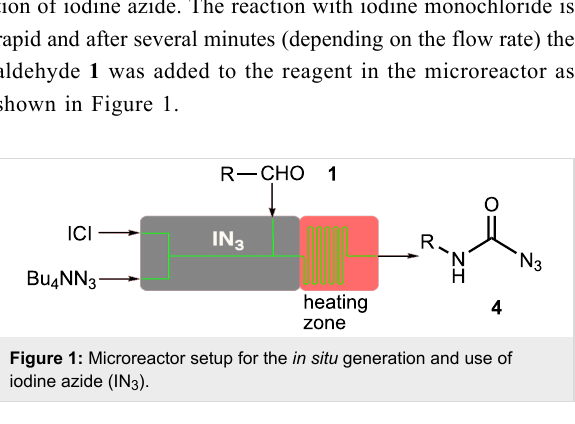
All reagents and the aldehyde 1 were used as solutions in acet- onitrile. After mixing the aldehyde with the iodine azide reagent the solution is passed through a capillary (volume: 196 µL) in a heating zone to allow the Curtius rearrangement to occur. Flow